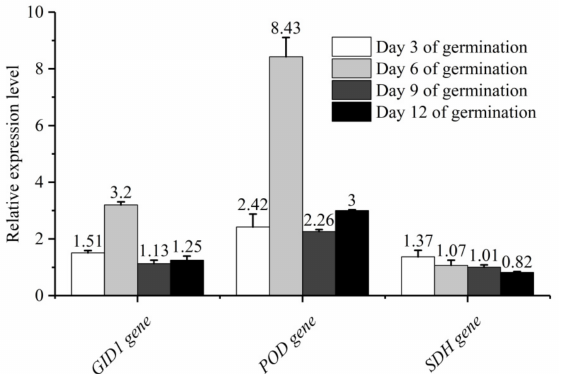
Figure 3. Effect of sand priming on genes expression in Pinus massoniana “Dai 1.0”. Annotation information of above genes had been listed in Table